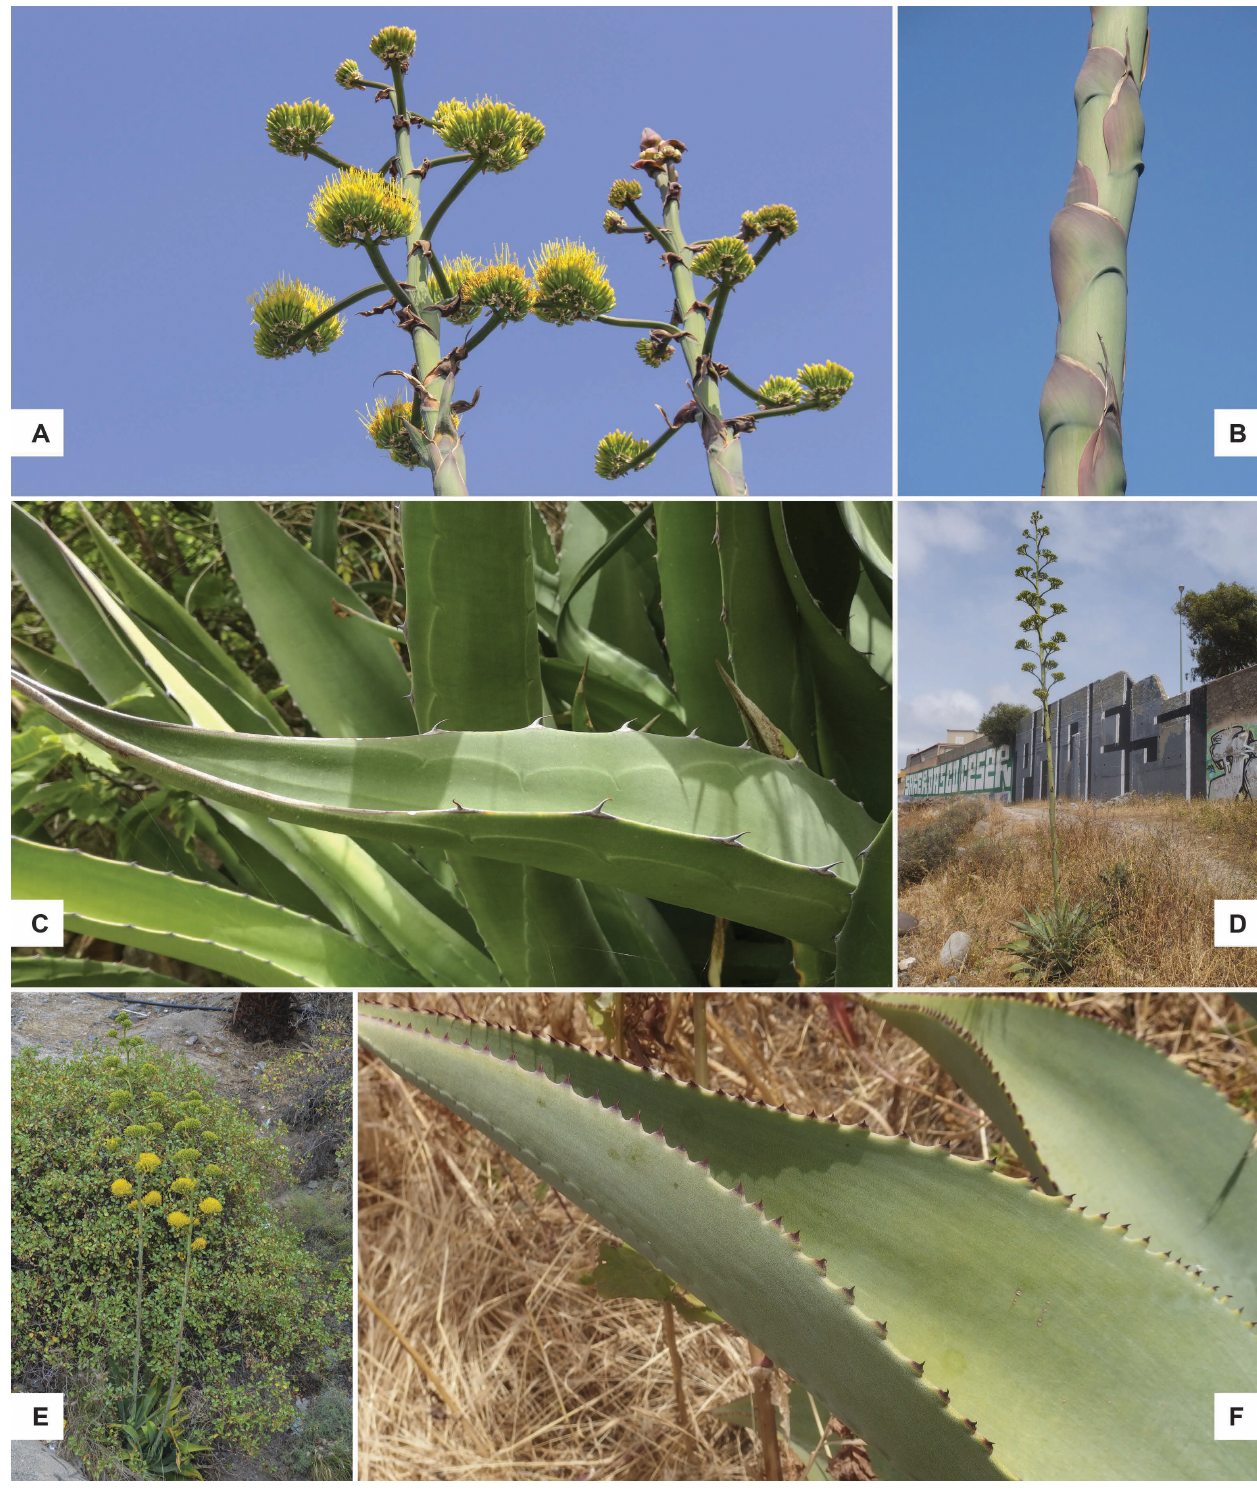
Figure 5 – A . Agave salmiana var. salmiana , Las Palmas de Gran Canaria (Los Hoyos) (C), August 2018. The inflorescence in this species is hardly longer than wide and more or less pyramidal. B . Idem, April 2018. Inflorescence bracts in this species are triangular and fleshy. C . Idem, Arafo (T), July 2018. In this species leaves are green with a long-decurrent terminal spine. D . A. vivipara , Las Palmas de Gran Canaria, Lomo La Cruz (C), April 2018. E . Idem, May 2018. Flowers of this species are bright yellow. F . Idem, April 2018. Detail of leaf spination. Photographs: A by M. Salas Pascual; B, D, F by F. Verloove; C by A. Reyes-Betancort; E by Á.